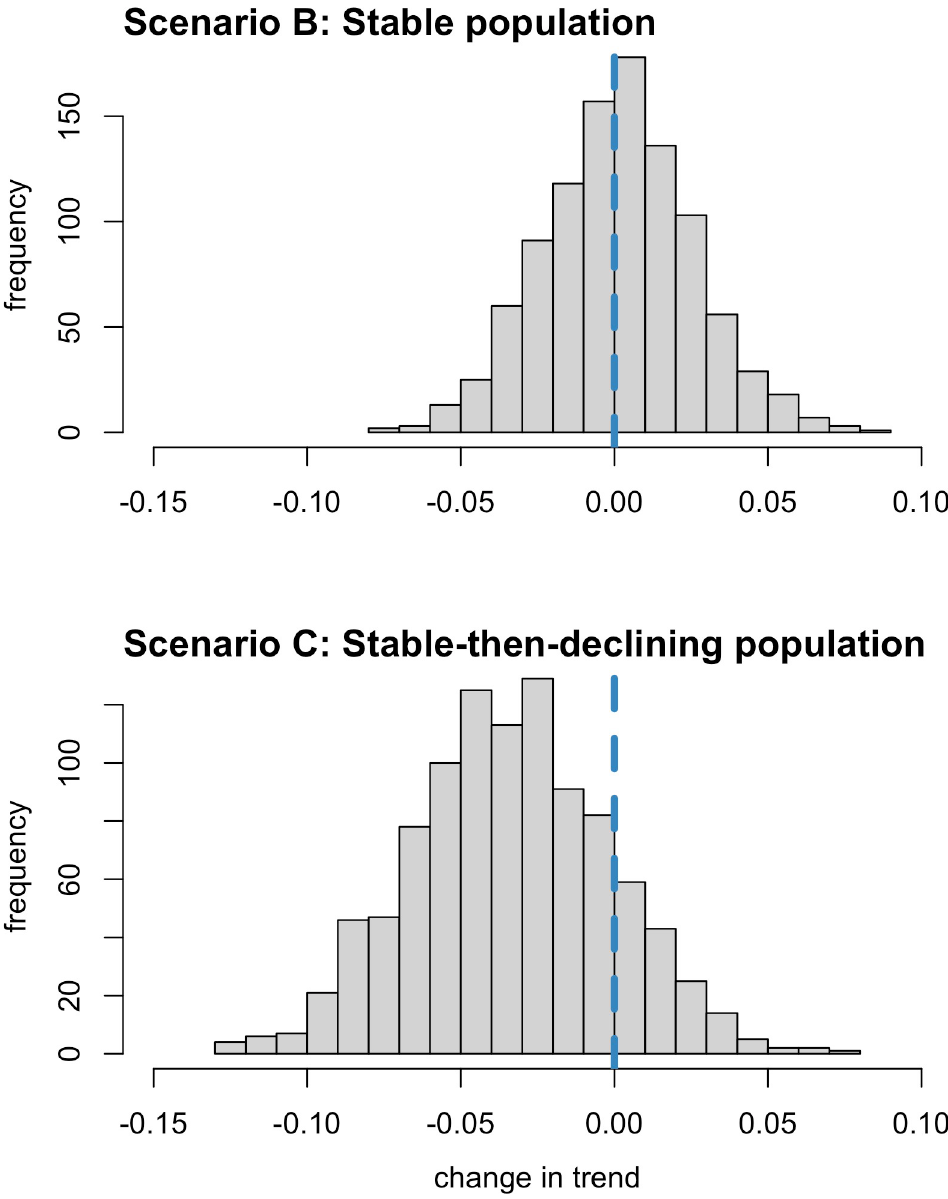
Fig 6. Posterior distributions for change in trend under Scenario B (stable population in shifting habitat) and Scenario C (stable-then-declining population in randomly varying habitat) estimated by Model 4 (change-in-trend version). The blue dashed line indicates no change in